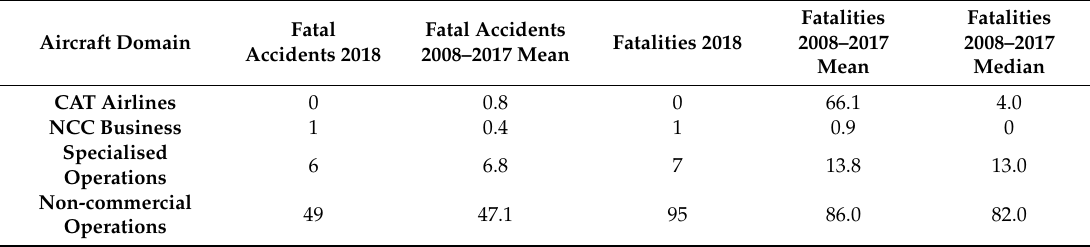
Table 2. Cross-Domain Comparison of EASA MS Aircraft Fatal Accidents and Fatalities,